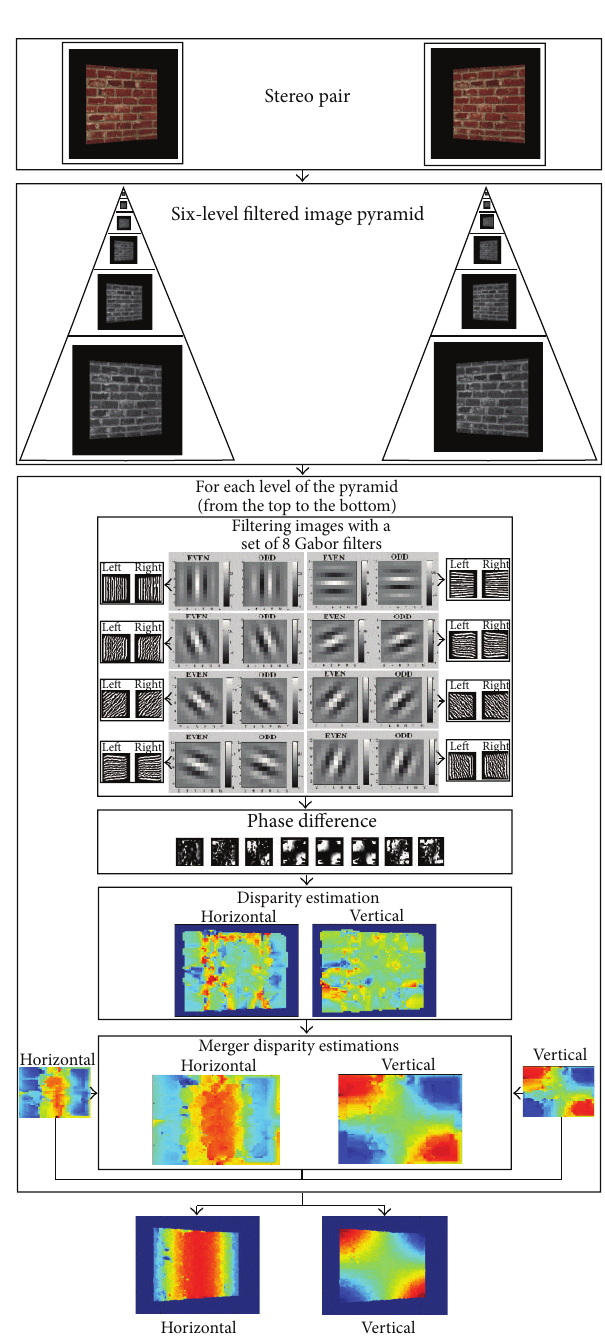
Figure 4: Graphical description of the phase-based binocular disparity estimation (PBBDE) approach: from a captured stereo image pair, an 𝑛 -level image pyramid is built such that a spatial filter is applied to each level for noise reduction. Then, for each level, the images are filtered with a set of eight complex-valued Gabor filters, followed by a phase difference estimation and a following disparity estimation. Finally, the obtained disparity is integrated with the disparity map obtained in the previous